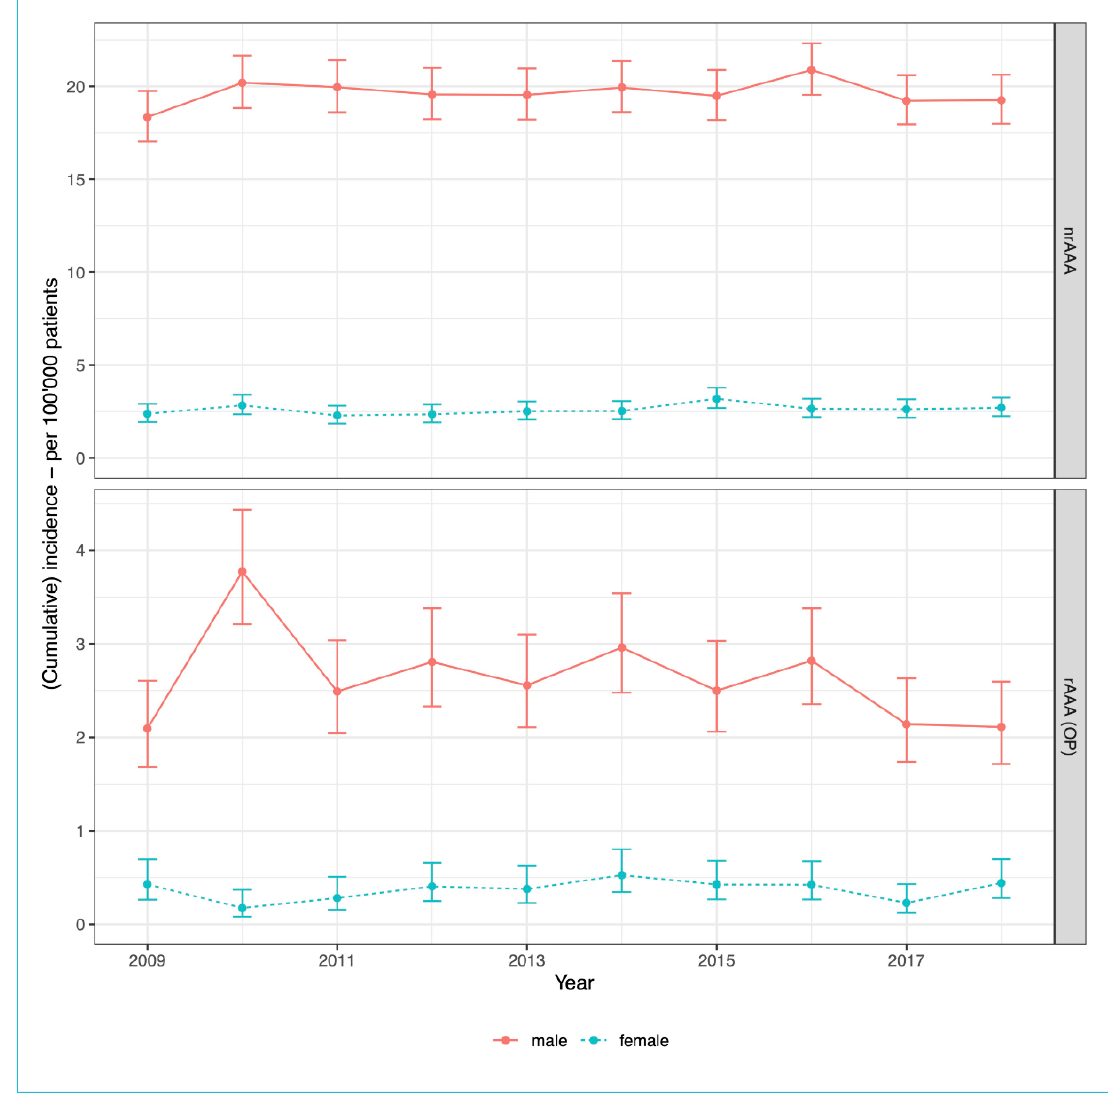
Figure 2: Incidence of abdominal aortic aneurysm (AAA). Standardised incidence rates are presented with 95% confidence intervals for each year and stratified by sex and diagnosis (nonruptured [nrAAA] versus ruptured [rAAA] aneurysms). To increase readability, the y-axis was dif- ferent for nrAAA and rAAA